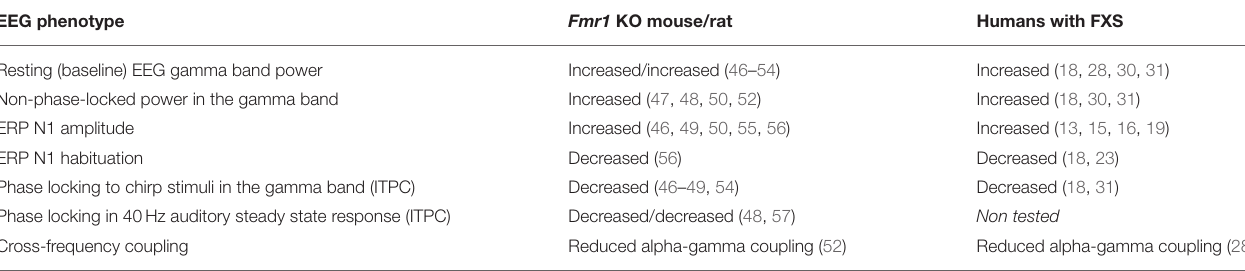
TABLE 1 | Species similarity in EEG